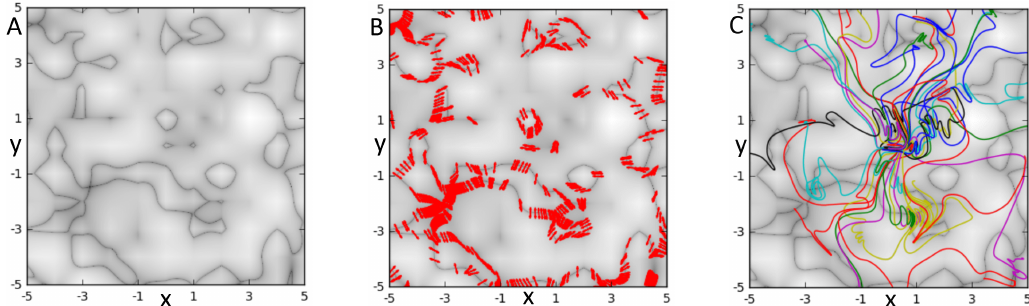
Figure 4: Example of null geodesic collimation. We use a spacetime defined by v = y in the purely nematic model of Eqs. (51a) and (51b). A: Heat map and v N of the time-dilation factor γ [ Eq. (25) ] , depicting curvature singularities along unit circle. B: Heat map annotated to mark the collimation angles of the singularities. C: Heat map with null geodesic trajectories superimposed. Note that the geodesics pass through the singular manifold at the correct collimation angles. We can also see some geodesics arc back into metastable orbits along the singular manifold.